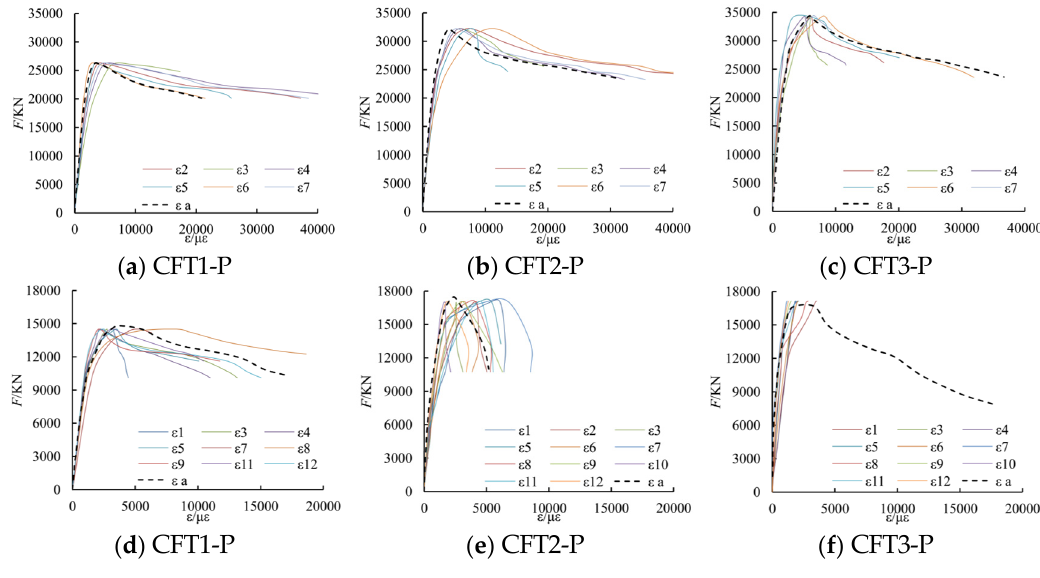
Figure 9. Backbone curves of F ‐ε i .